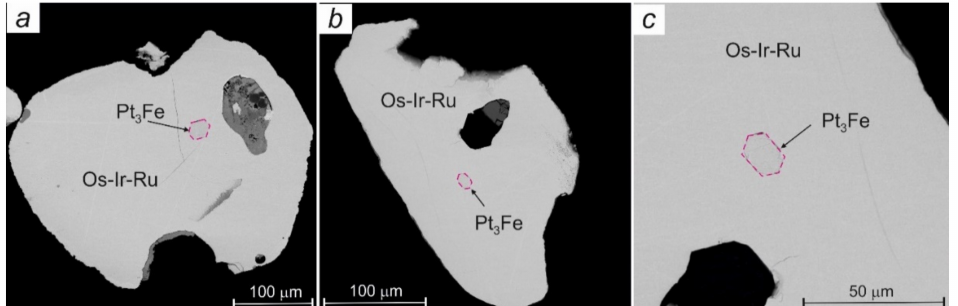
Figure 4. BSE images showing idiomorphic inclusions of Pt-Fe alloy hosted by a grain of Os-Ir-Ru alloy: ( a ) A partly rounded grain of Os-Ir-Ru alloy containing an idiomorphic inclusion of Pt-Fe-alloy; ( b ) silicate inclusion and inclusion of isoferroplatinum in Os-Ir-Ru alloy; ( c ) idiomorphic inclusion of isoferroplatinum in Os-Ir-Ru